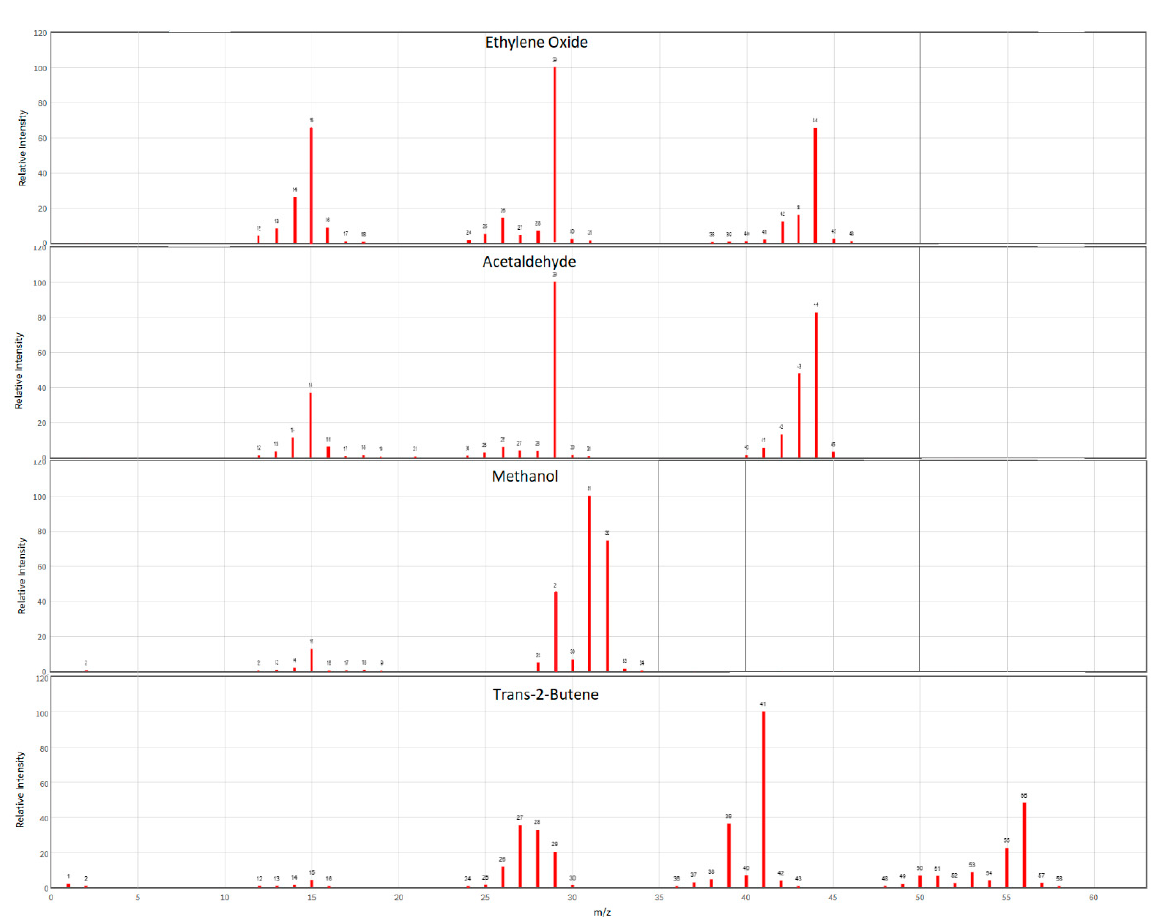
Figure A1. Mass spectra of EtO (top) and potential coelutions. Mass spectra taken from NIST database.